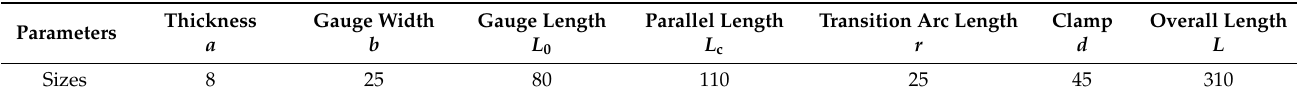
Table 2. Size of the coupon (units: mm).